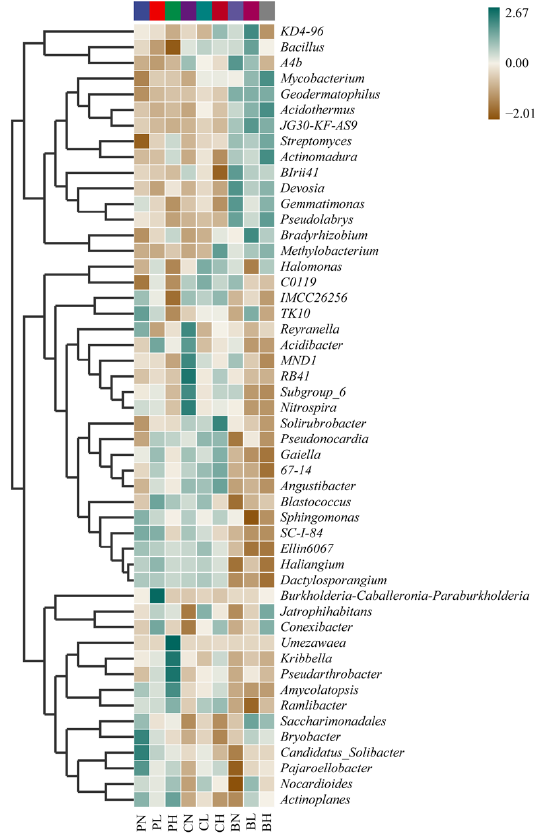
Figure 3. The heatmap showing the abundance of the top 50 genera. Color codes were based on standardization (row) of species abundance (see scale on the top right). P, C, and B represent hydroxyapatite addition, no amendments, and biochar addition, respectively. L, N, and H represent low planting density, no planting, and high planting density, respectively. Pseudonocardia , and Ramlibacter in the soil without SRAs, but diminishing Reyranella , Acidibacter , MNDI, RB41, Subgroup_6, and Nitrospira